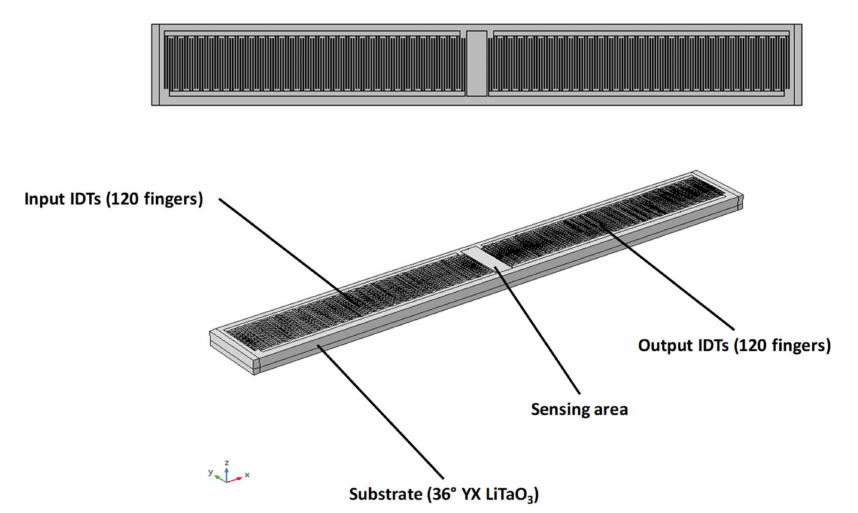
Figure 3. FEM 3D geometry of SAW device.